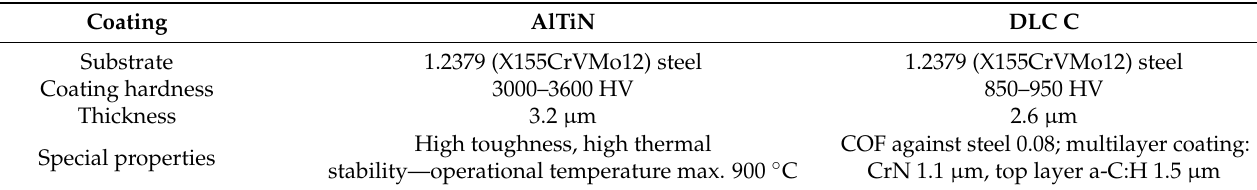
Table 1. Main properties of coatings used in the experiment.